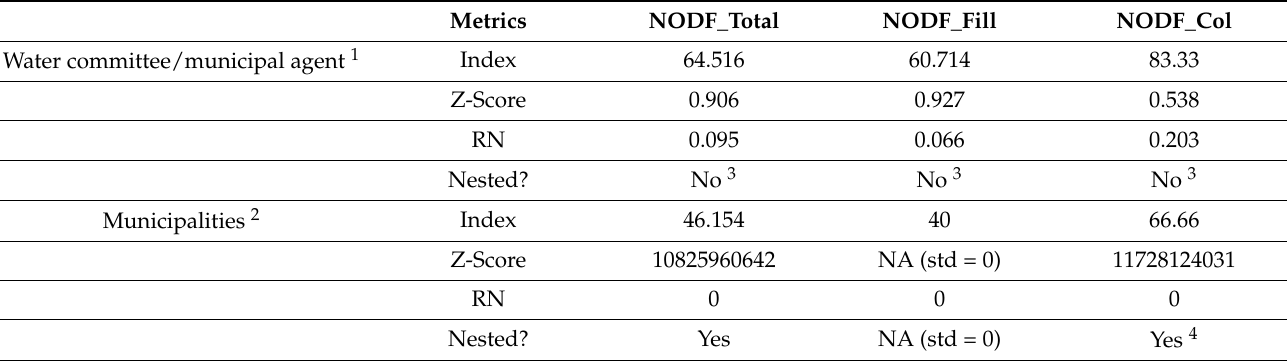
Table 4. Nestedness results obtained with the Nestedness based on Overlap and Decreasing Fill (NODF) algorithm in the Nestedness for Dummies (NeD) online software for two groups: (1) communities in which water committees and municipal agents are responsible for supplying the water for domestic use and (2) municipal seats in which the municipality is